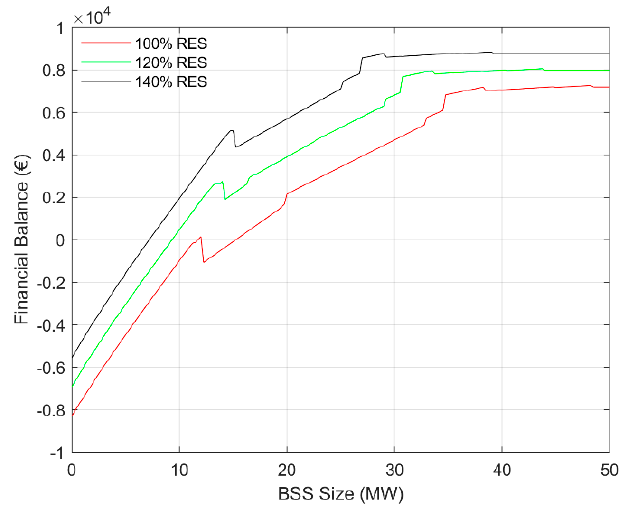
Figure 4. MGO’s financial balance as a function of BSS size (optimal FlexAsset sizing to maximize MGO’s profits).